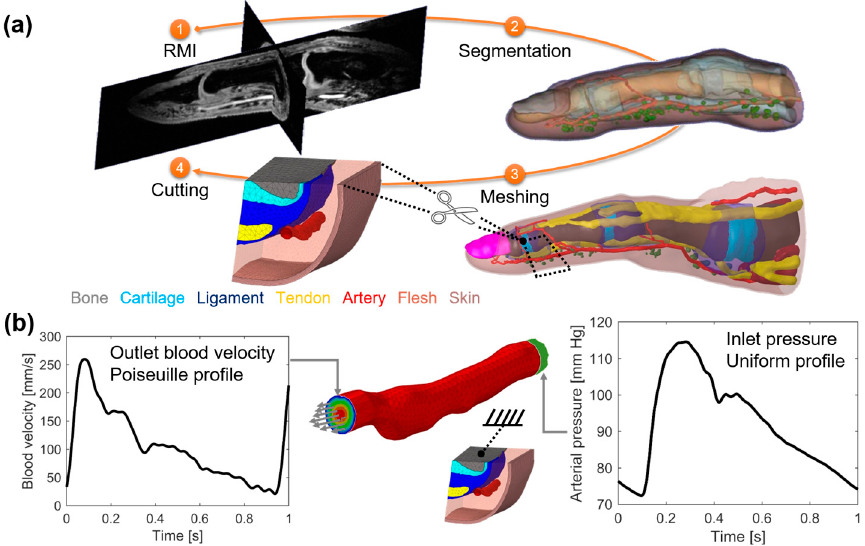
Figure 7. ( a ) Workflow for the mesh construction showing the RMI images, segmentation, meshing, and cutting stages; ( b ) pressure inlet and velocity outlet physiological boundary conditions, and clamped bone, from [68].